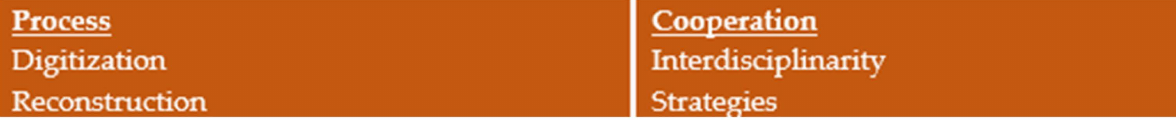
Figure 12. Chapter